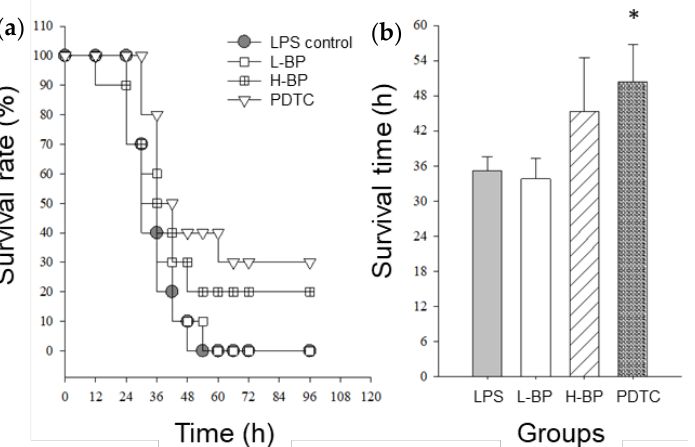
Figure 5. The effects of BP-95E-H 2 O-BuOH extract administration on the survival rate of mice challenged with LPS. The BALB/c mice were tube-fed with BP-95E-H 2 O-BuOH extracts at doses of 44 (L-BP group) and 166 mg/kg b.w. (H-BP group) for two weeks before the LPS challenge, whereas the mice in the PDTC group were i.p. injected with 50 mg PDTC/kg b.w. 1 h before the LPS challenge. The survival of each group of mice was recorded and is expressed as the survival rate ( a ) and survival time ( b ). A significant difference from the control is indicated as * p < 0.05 according to Student’s t -test.